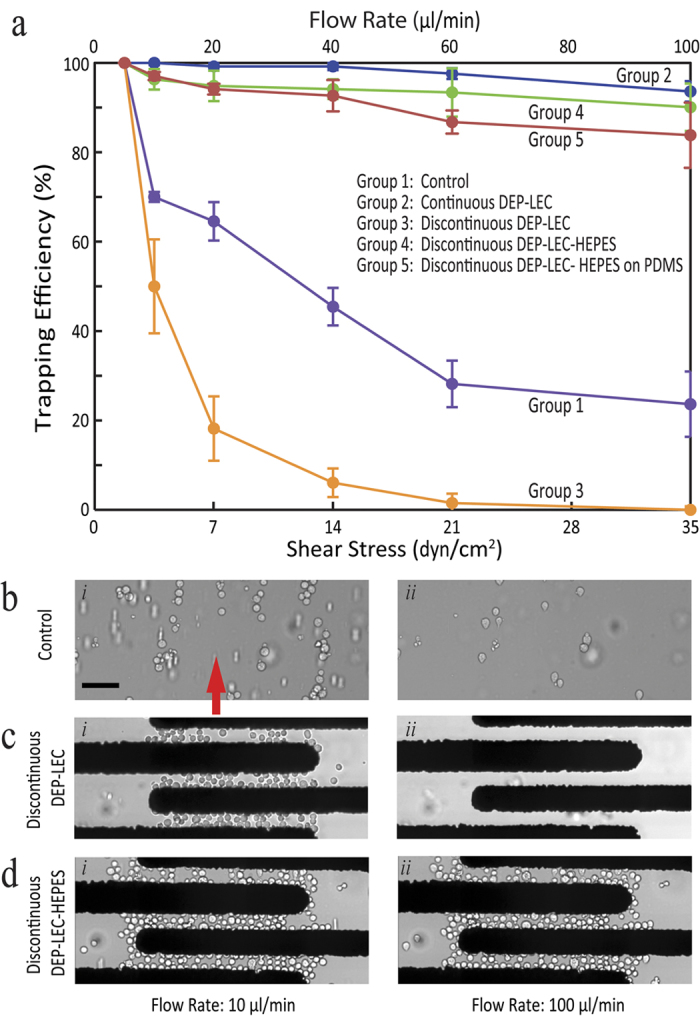
Cell Trapping Efficiency.(a) The trapping efficiency obtained for experimental groups one to five. (b–d) Images compare the cell population for experimental groups one, three and four, obtained at the flow rates of 10 and 100 μl/min. Group-one: no electric field is used to immobilise cells with cells suspended in HEPES, group-three: discontinuous DEP after 120 s with cells suspended in LEC, and group-four: discontinuous DEP after 120 s, after which the medium is changed to HEPES. The flow direction is indicated by the red arrow and applies to all presented experimental images. Data is representative of three to five independent experiments and error bars indicate mean ± SEM. Scale Bar: 50 μm.